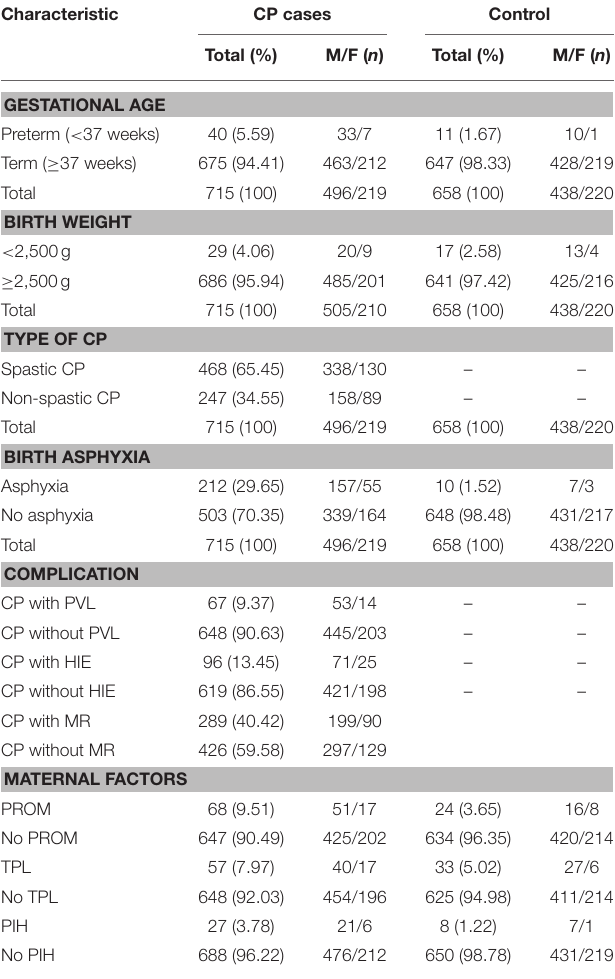
TABLE 1 | Clinical characteristics of all